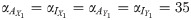
The system behavior in parameter space, and evaluation of the effect of parameters’ changes for Eq 1.In the 5 × 6 array, each cell represents the X − Y phase plane, X−, and Y−nullclines, for parameter values as indicated at the bottom of each subplot. The magenta regions represent the steady states domains. The basic set of parameters are chosen from Table 1, αAX1=αIX1=αAY1=αIY1=35, β = 45, γ = 0.38, and n = 4.